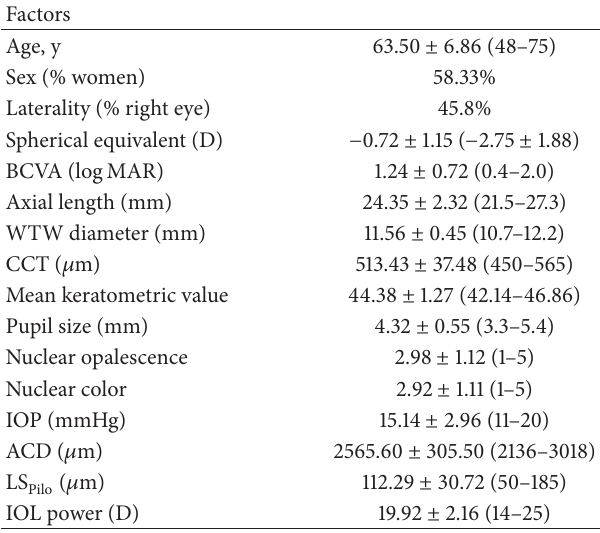
Table 1: Preoperative clinical characteristics in eyes enrolled in this study ( 𝑛 = 24 ).